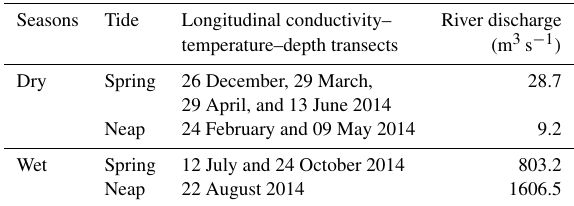
Table 1. Sampling